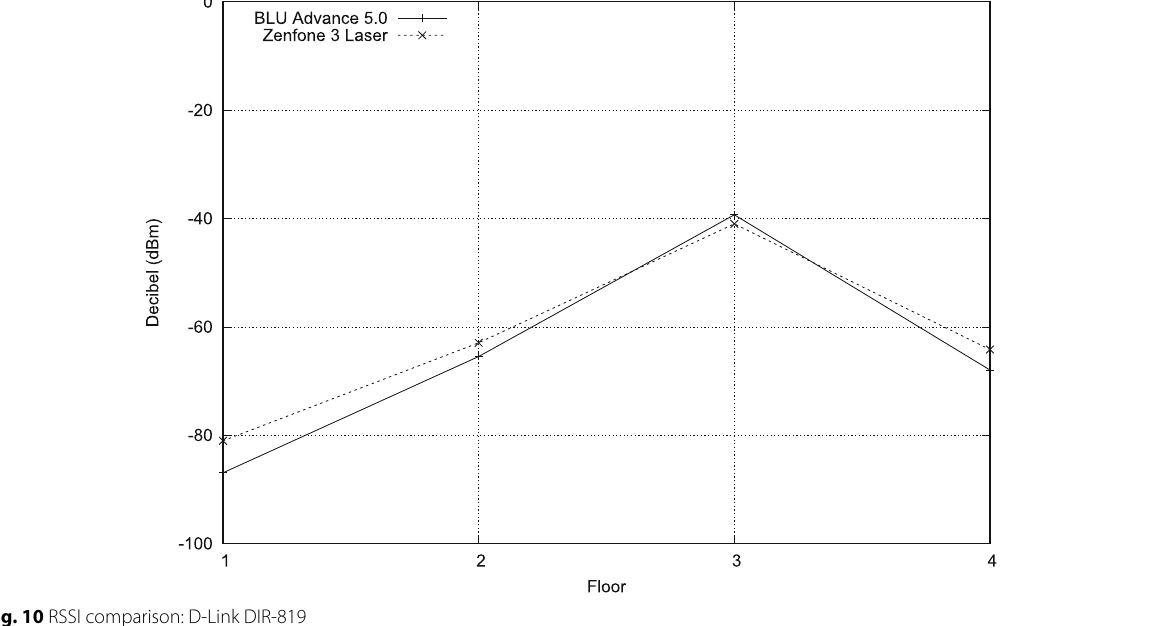
Fig. 10 RSSI comparison: D-Link